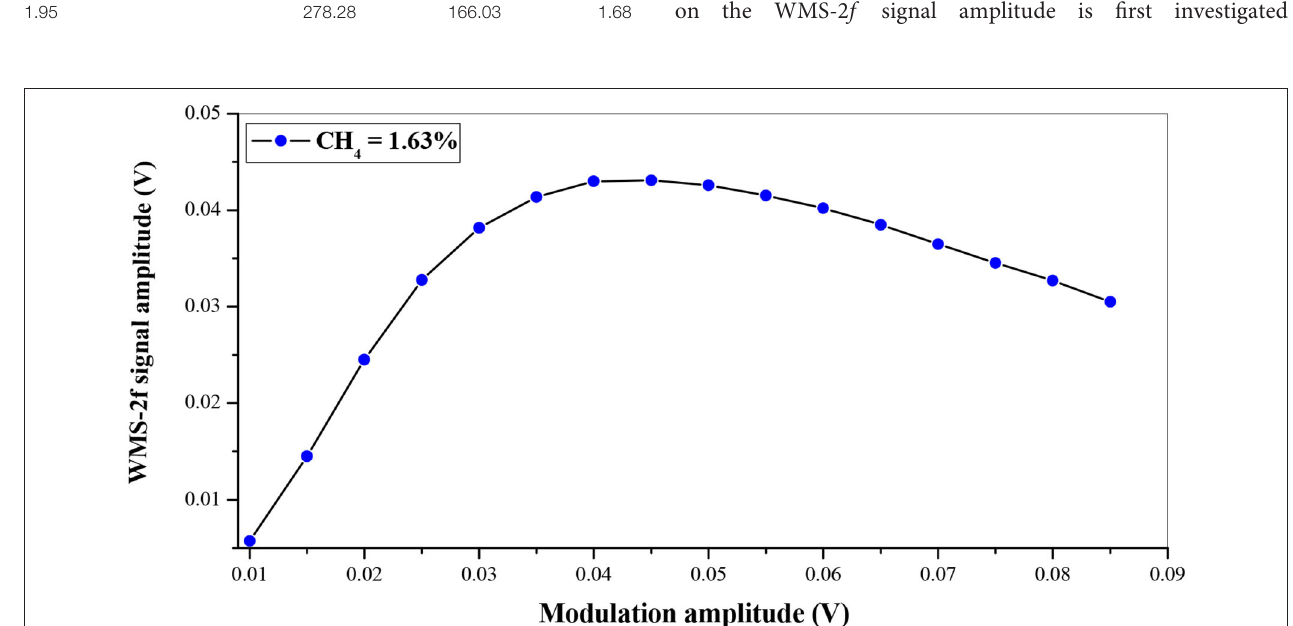
Frontiers in Physics |